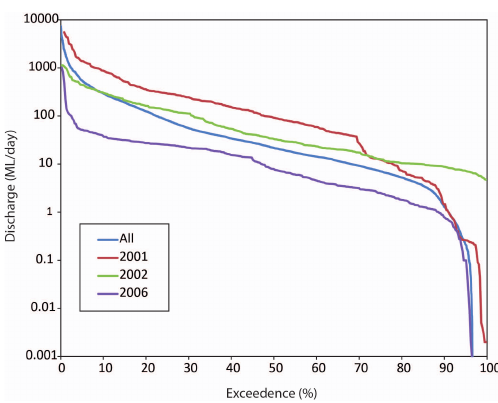
Fig. 6. Flow duration curve for the upper Barwon River in 2001, 2002, 2006, and for all years between 2001 and 2011. Data from Water Resources Data Warehouse